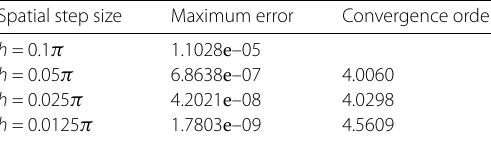
Table 4 The convergence order for R-CFDS4 at τ = 0.0002